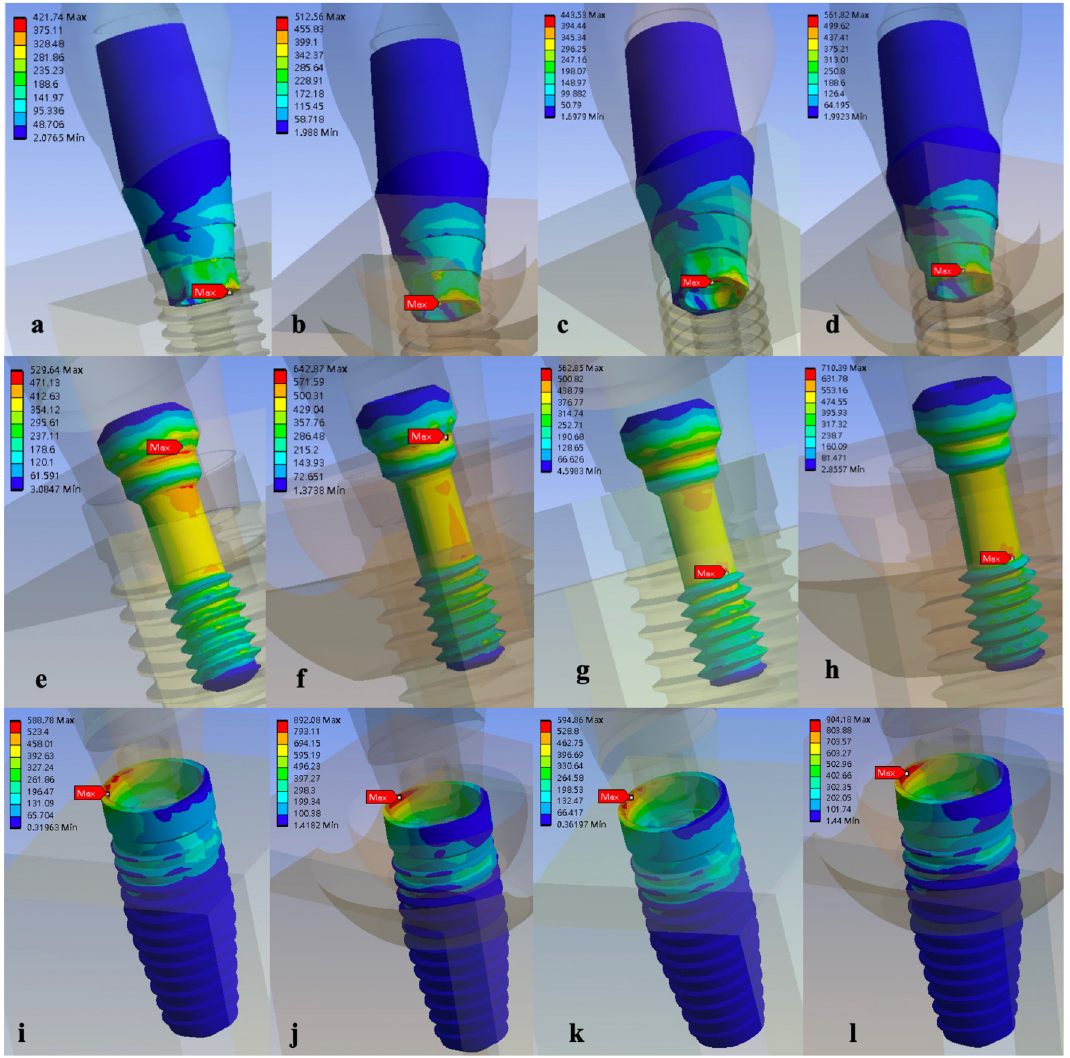
Figure 6. Stress distribution and maximum von Mises stress of the four models under the same loading conditions of ( a ) Model 1, ( b ) Model 2, ( c ) Model 3, and ( d ) Model 4; in the screw of ( e ) Model 1, ( f ) Model 2, ( g ) Model 3, and ( h ) Model 4; and in the implant of ( i ) Model 1, ( j ) Model 2, ( k ) Model 3, and ( l ) Model 4.